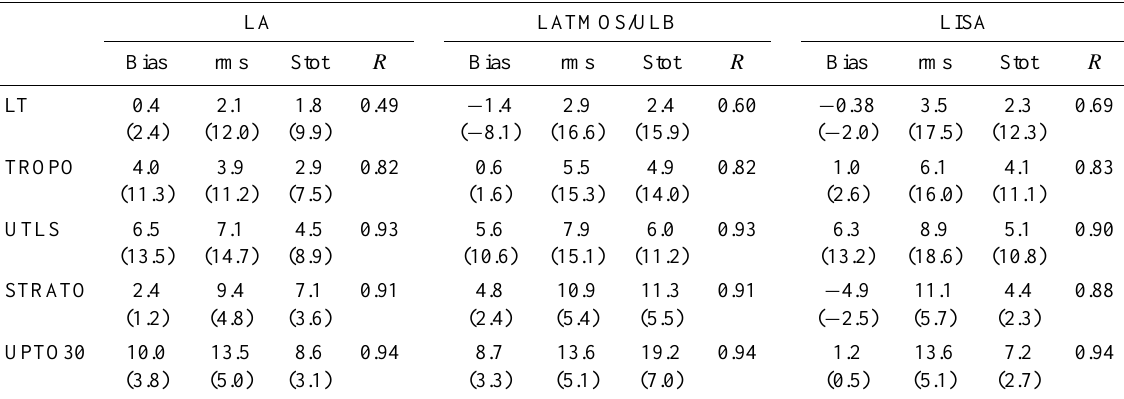
Table 6. Statistics of the comparison between the three IASI ozone products and the ozonesondes for the midlatitudes. The bias (IASI- sondes), the rms of this difference and the corresponding correlation coefficient are given for different partial columns. Theoretical total error estimates (Stot) is also displayed for the corresponding partial columns of ozone. The bias, the rms, and Stot are given in DU and in percent (in